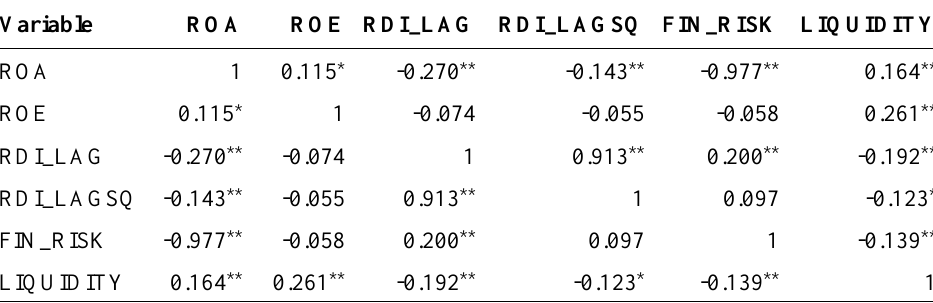
Table 2: Correlation Matrix